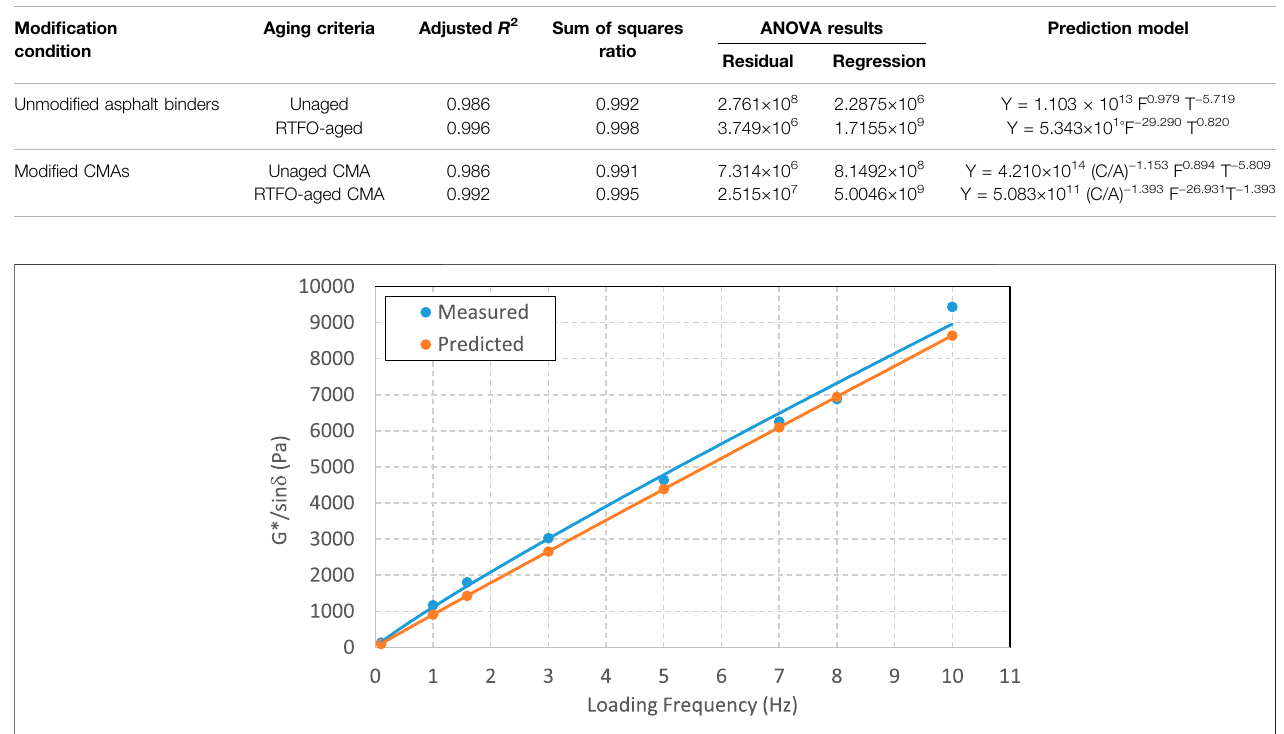
TABLE 4 | Nonlinear regression models of rutting parameter for the unaged and RTFO-Aged CMA binders.